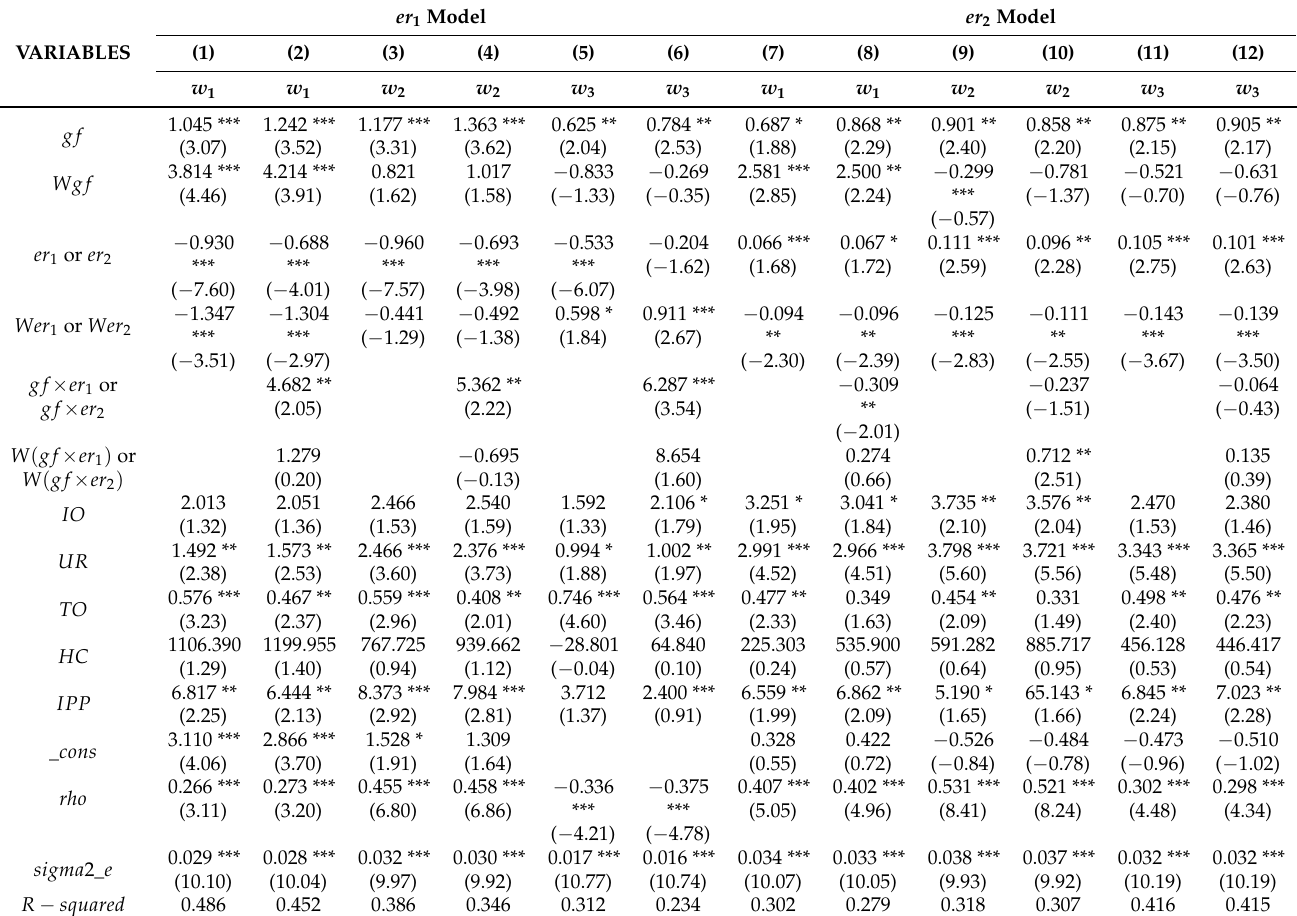
Table 6. Spatial regression results of er 1 model and er 2 model under w 1 , w 2 , w 3 weight